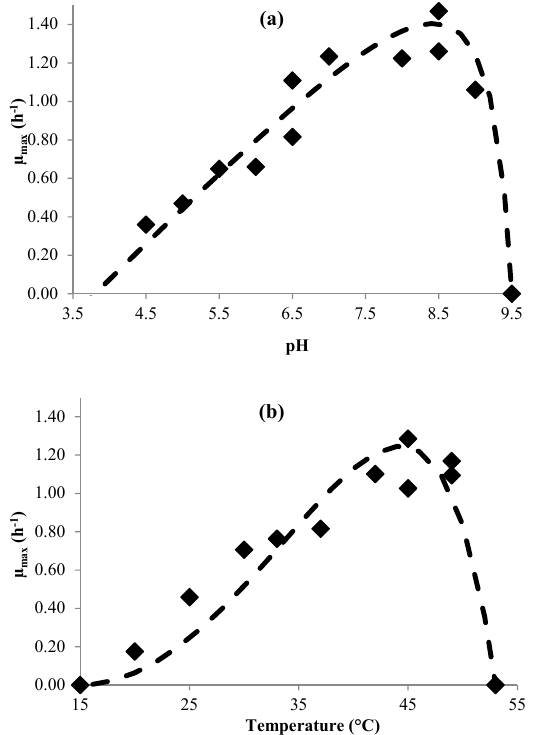
Figure 4. Effect of environment factors on growth rate of L. brevis . ( a ) pH effect and ( b ) temperature Experimental data (symbols) and predicted (continuous lines).